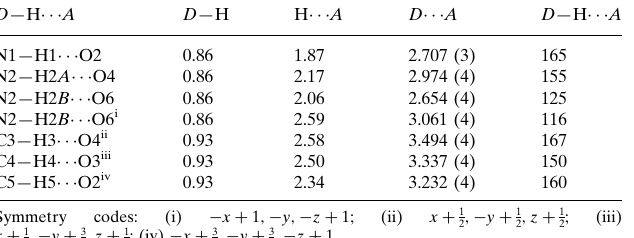
Hydrogen-bond geometry (A˚ , (cid:2)